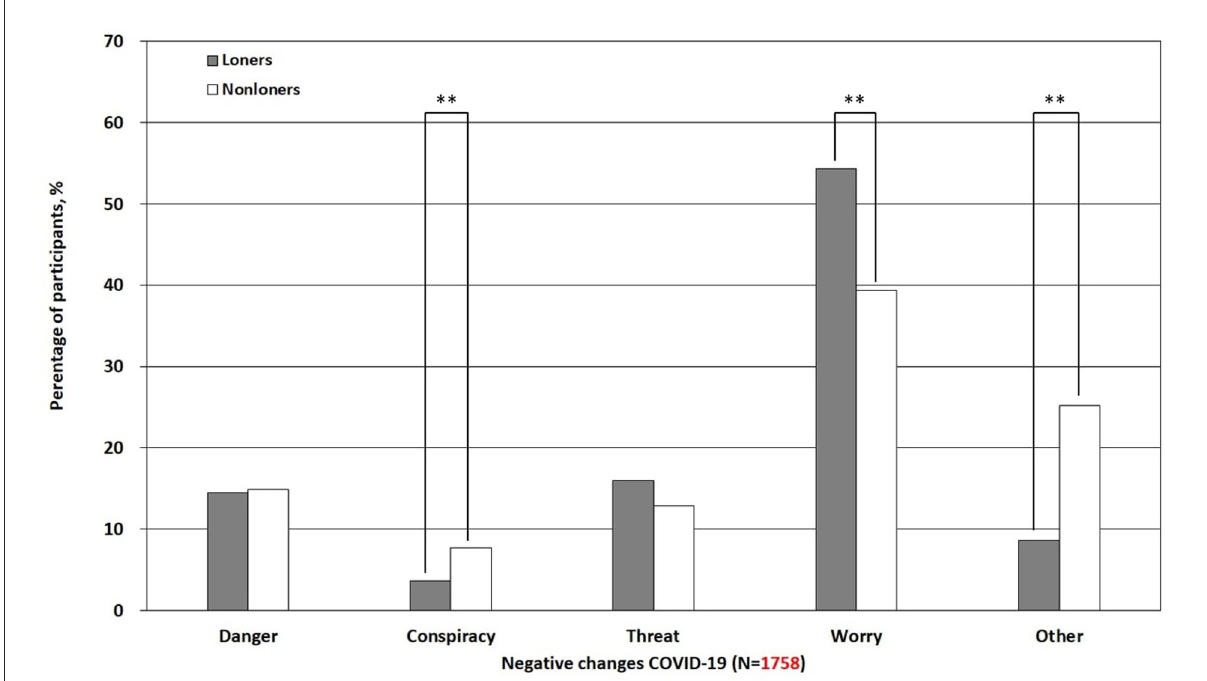
FIGURE2 Differences in negative experiences of living in the COVID-19 pandemic among lonely and non-lonely individuals. ** p <